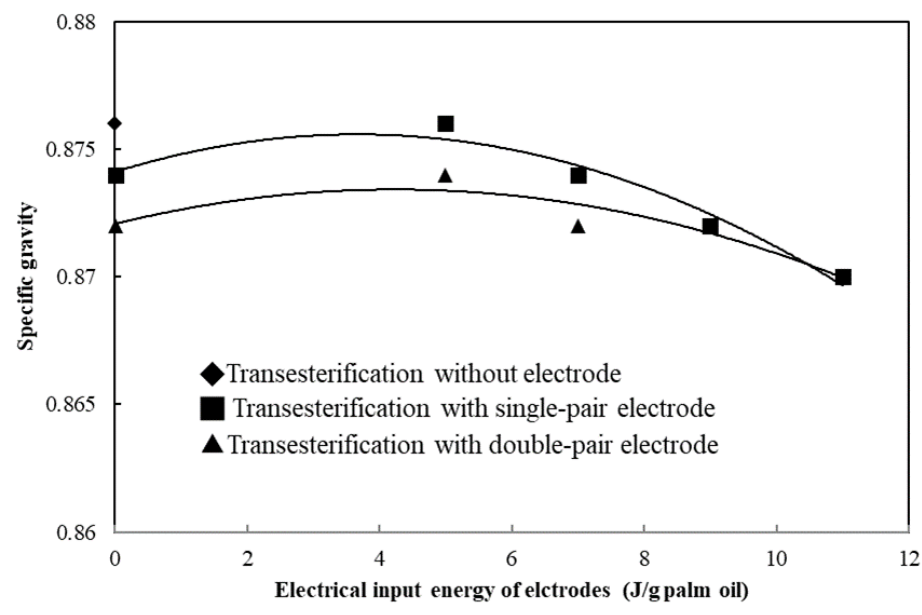
Figure 7. Effects of electrical energy input to electrodes for dissociating water on the specific gravity of biodiesel product.